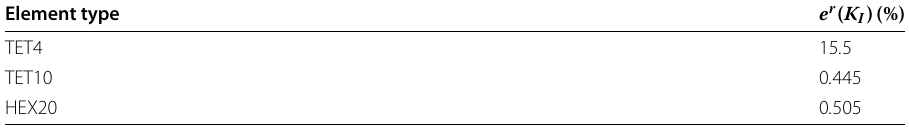
Table 4 Relative error of stress intensity factor K I extracted from the HNA Abaqus-ISET solution of the surface crack problem Element